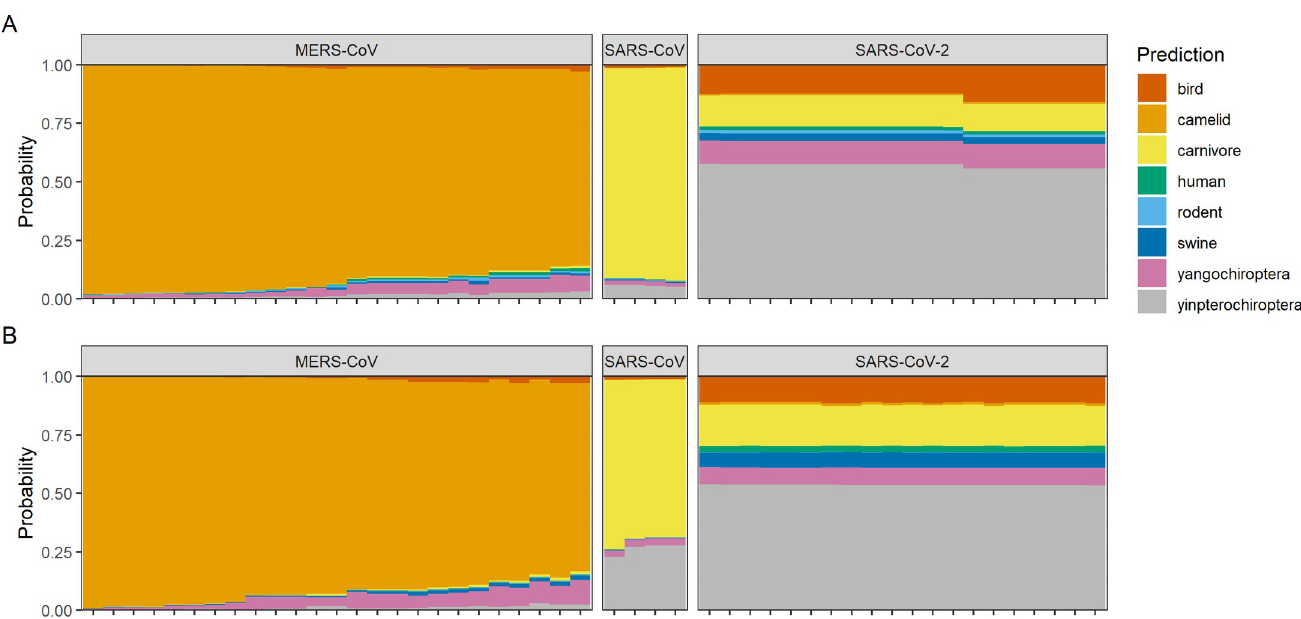
Fig 4. Random forest predictions based on zoonotic coronavirus genome composition. Stacked bar plots of predicted probabilities of each host category for zoonotic coronavirus sequences sampled from humans. Predictions were obtained from ensemble random forest models trained on A) spike protein and B) whole genome composition features. Colour coding denotes model-predicted host category. Stacks represent individual coronavirus sequences.